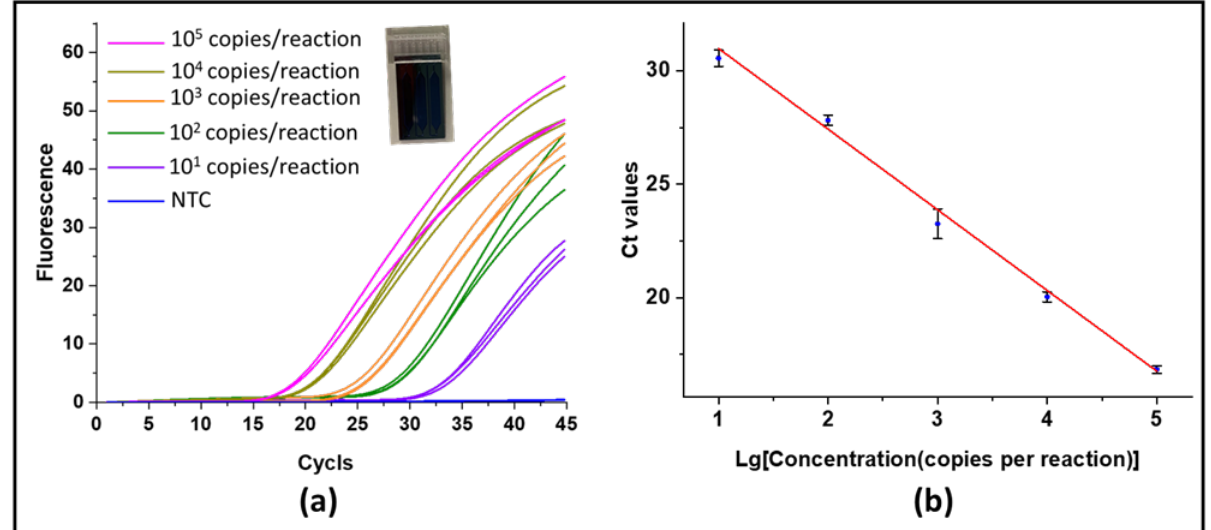
Figure 9. ( a ) Real-time PCR amplification results with three-channel silicon-based chips on digital PCR platform. The HBV plasmid concentrations were 10 1 , 10 2 , 10 3 , 10 4 , and 10 5 copies per reaction, respectively, and the NTC group is not a template control group. ( b ) Standard curve for HBV plasmid quantification.